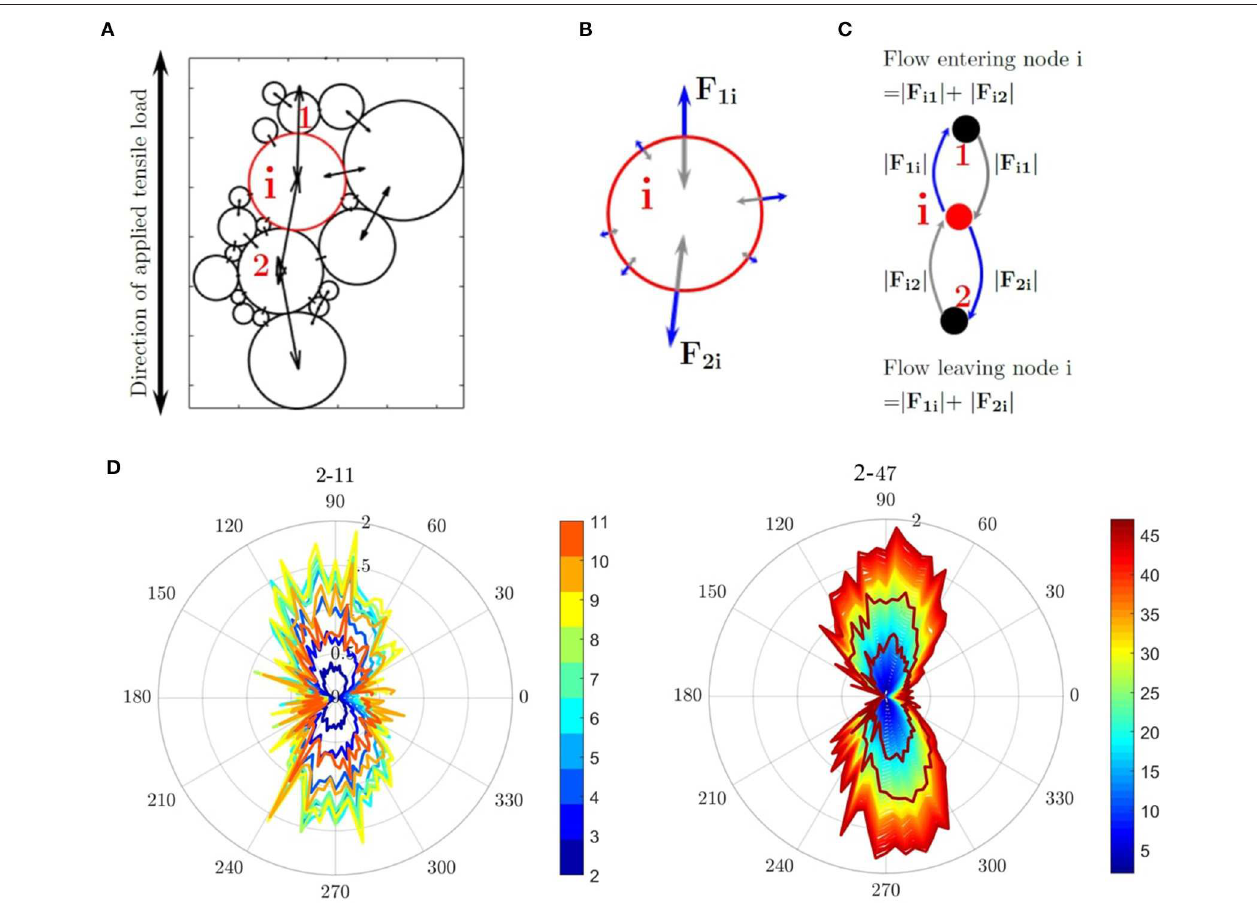
FIGURE 6 | (Color online) Mapping the bonded contact network to the flow network. (A) Representative grain cluster embodying a tensile force chain with member grains { 1, i , 2 } , taken from DI. Dominant normal tensile forces on grain i are aligned in the direction of the applied tensile load. (B) Blue (gray) arrows correspond to forces acting on i from neighbor grains (forces from i acting on neighbor grains). (C) Depiction of the conservation rule: force flow out of node i = force flow into node i (for clarity, only the arcs transmitting the dominant forces are shown). (D) Conservation of tensile force flow evident in the symmetry of polar plots for normal tensile contact forces above and below the centroid of each grain [from stages 2 to 11 (47) for DI